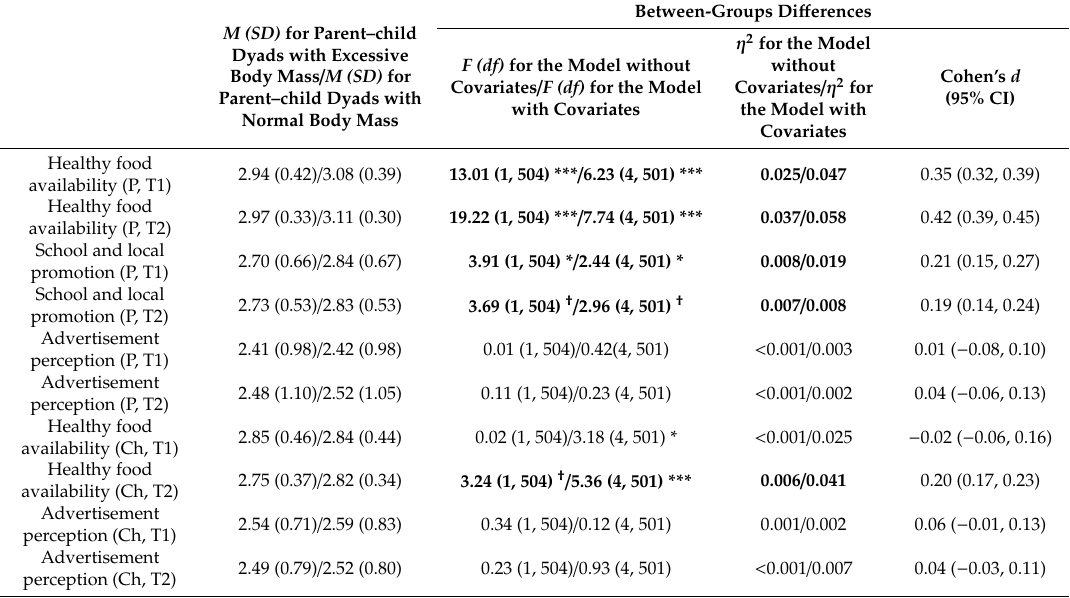
Table 1. Di ff erences in at-home and out-of-home environment: Comparisons of dyads of parents and children with excessive body mass ( n = 129) and dyads of parents and children with normal body mass ( n =